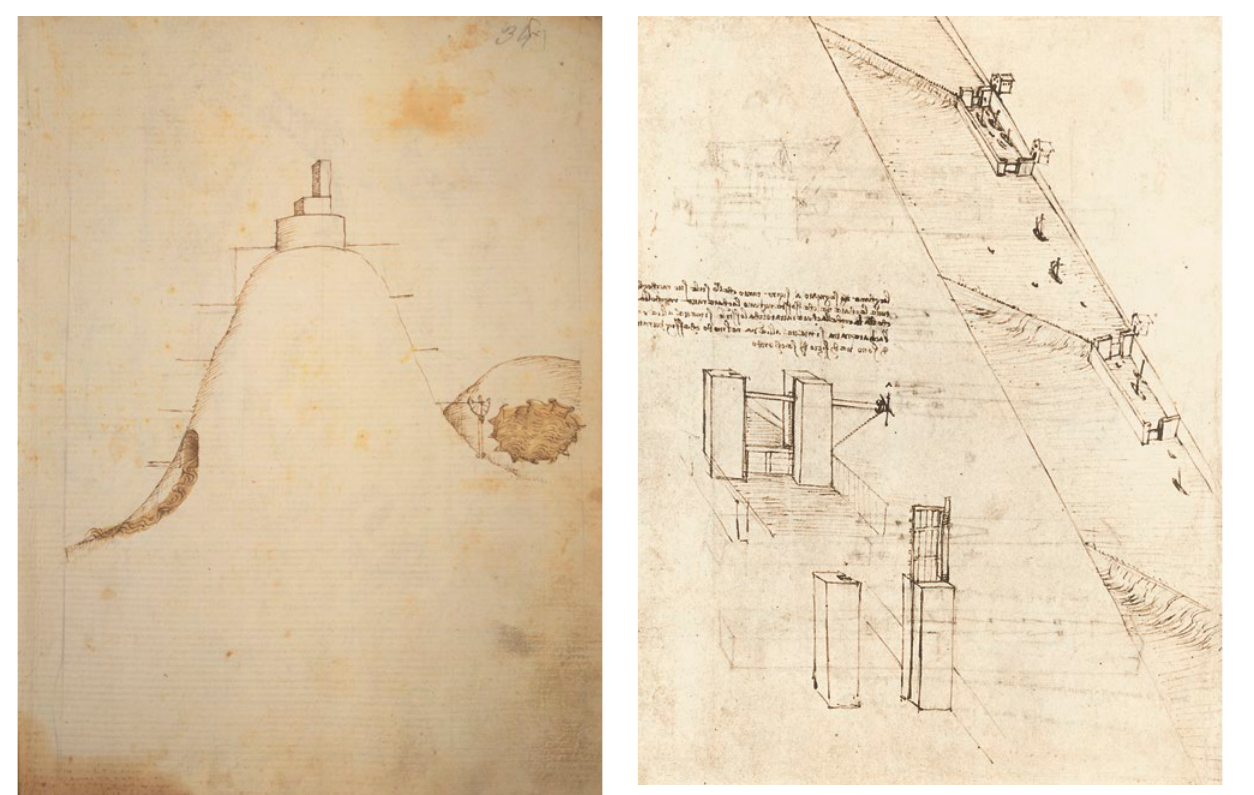
Figure 24. Mariano di Iacopo, called il Taccola, De ingeneis , Bibli- oteca Nazionale Centrale di Firenze, Ms. Palat. 762, c. 34r: method for digging a tunnel for the passage of canals and aqueducts.